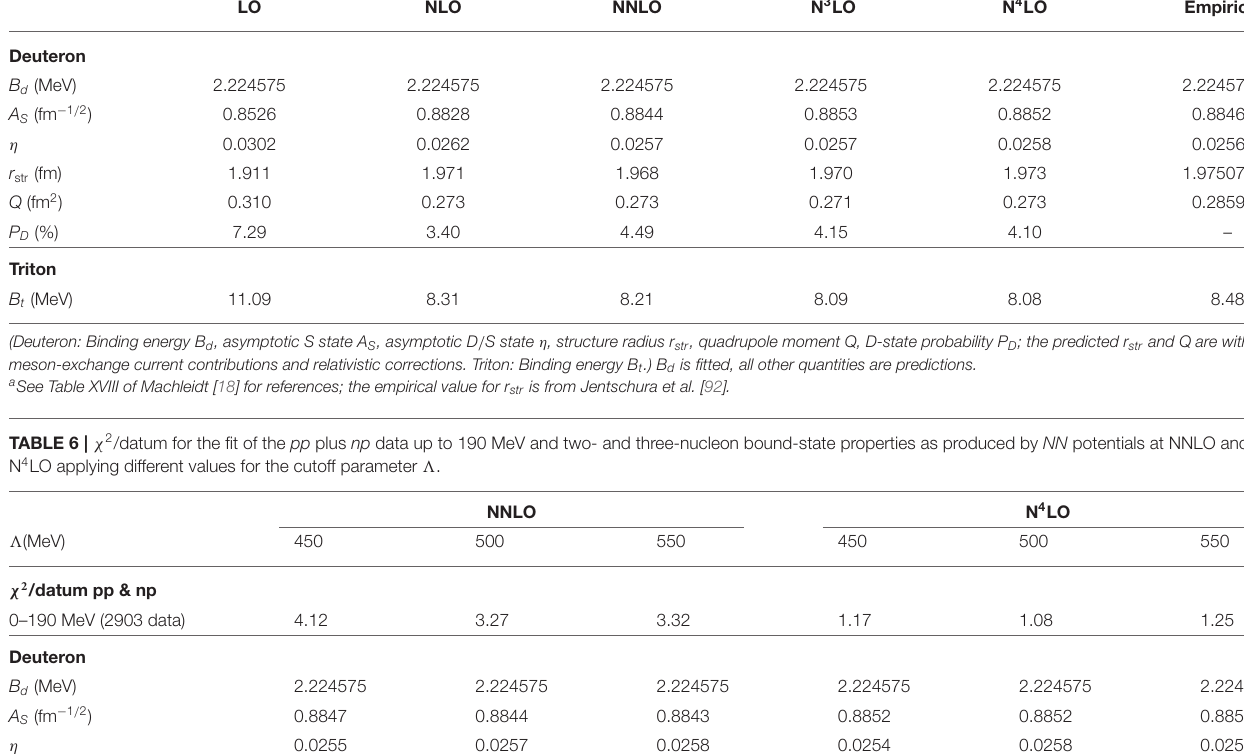
TABLE 5 | Two- and three-nucleon bound-state properties as predicted by NN potentials at various orders of chiral EFT ( 3 LO NLO NNLO N 3 LO N 4 LO Empirical a